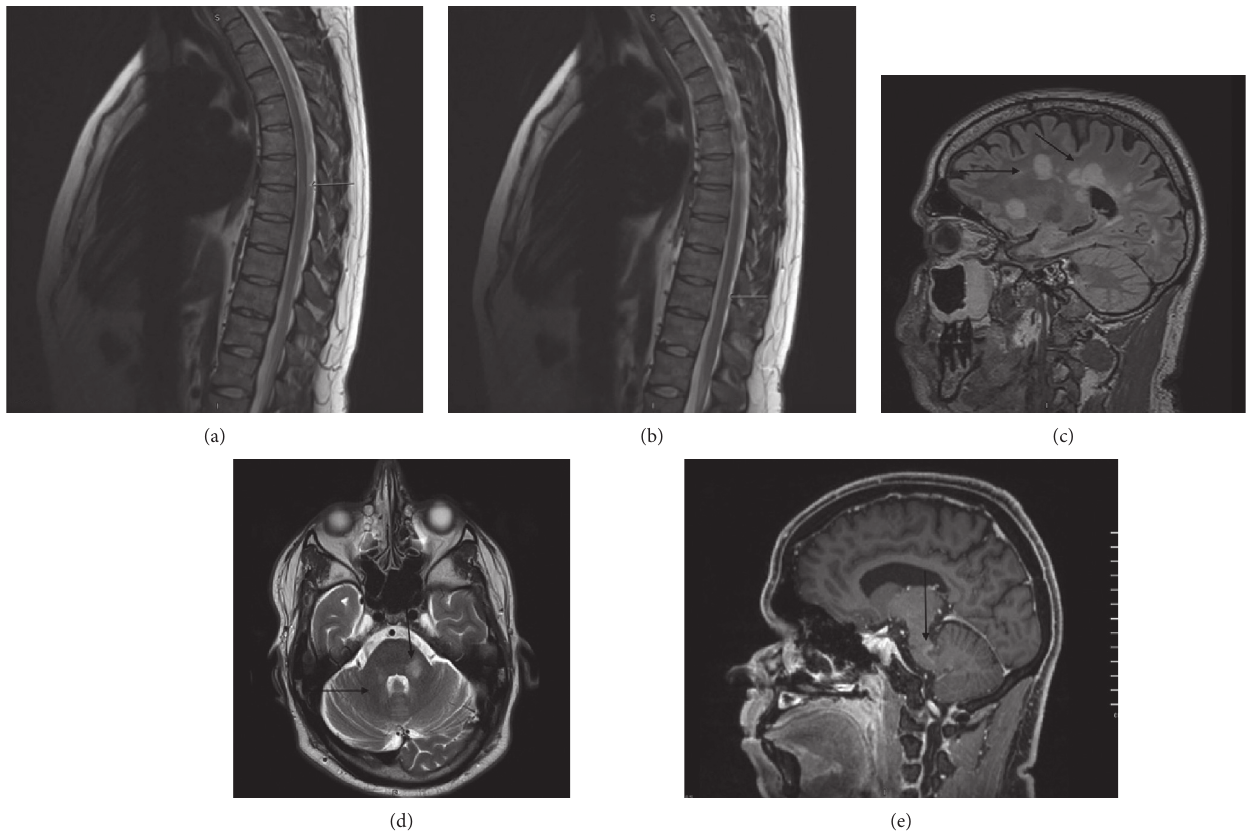
Figure 3: ((a), (b)) There are at least 2 definite high signal intensity plaques on the sagittal T2W1 seen at D6-7, D9-10 levels (arrow). ((c), (d)) Numerous bilateral variable-sized, different-shaped plaques of high signal intensity on T2W1/FLAIR seen mainly in the deep white matter at periventricular location and centrum semiovale, perpendicular callososeptal lesions, cerebellar peduncles, and cerebellar white matter. (e) Incomplete ring enhancement lesions seen in the left deep periventricular frontal lobe and left cerebellar